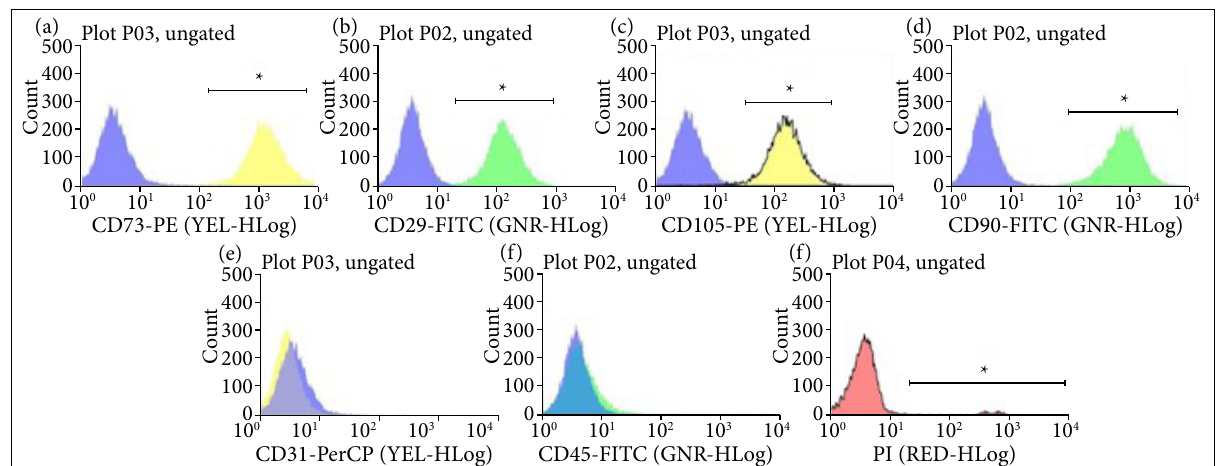
e anti-CD90 (Figs. 8a-8d), and negative for the endothelial cells marker anti-CD31 (Fig. 8e) and the hematopoietic cell marker anti-CD45 (Fig. 8f). Therefore, there is no contamination with other cell types in the fibroblast lineage used in this study. According to the dead cell marker, PI, there were only 5.03% dead cells.